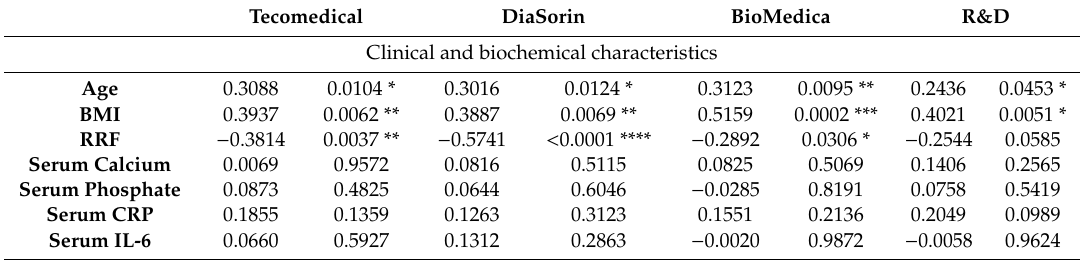
Table 9. Spearman correlation matrix of serum sclerostin concentration vs. demographic and biochemical